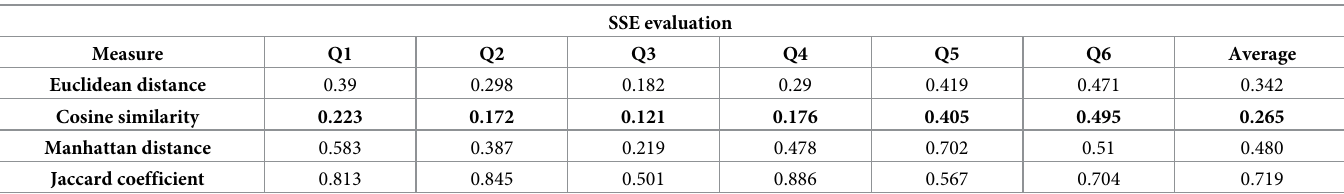
Table 2. Results of evaluation of similarity measures (best results in bold).